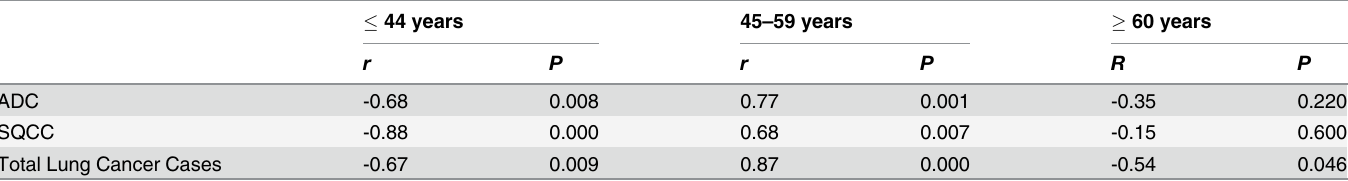
Table 2. Correlation between age group proportion and year period of lung cancer patients in CHCAMS from 1999 – 2012.